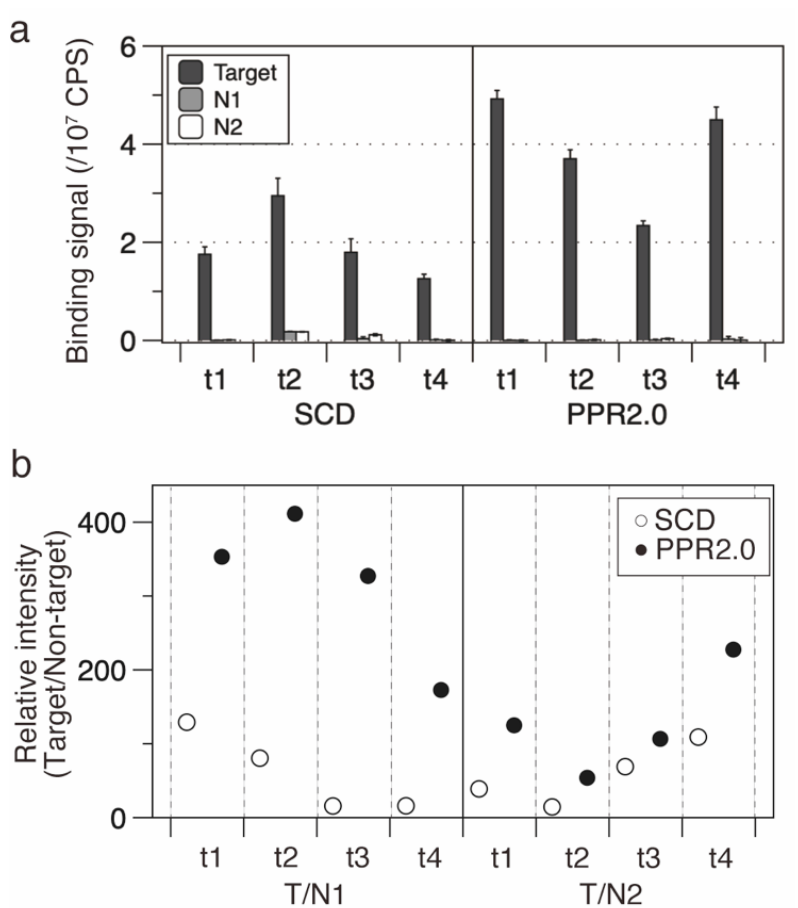
Figure 2. Designer PPR proteins of the PPR2.0 scaffold have higher binding activities and selectivities than those of the SCD scaffold. ( a ) RBP-ELISA for SCD and PPR2.0 scaffold proteins. Four PPR proteins were subjected to analysis using their respective target sequences (t1, t2, t3, and t4) or two non-target sequences (N1 and N2). ( b ) RNA binding selectivity. The selectivities of the SCD and PPR2.0 scaffolds were examined and plotted by estimating relative intensities, which are the signal intensities of target RNA against those of non-target RNA.